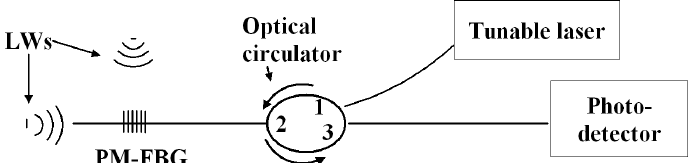
Figure 3. Schematic diagram of edge filtering-based Lamb wave interrogation systems for Polarization-maintaining Fiber Bragg grating.